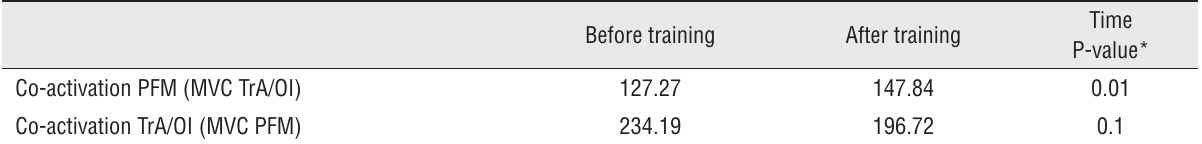
Table presents muscular response (co-activation) following MVC of PFM or TrA/OI, comparing the time of evaluation before and after training. Values expressed in percentage (5). Note increase of co-activation of PFM when MVC was solicited to TrA/OI pfM = pelvic floor muscles MvC = maximal voluntary contraction TrA/OI = transversus abdominis/oblique internal *ANOvA for repeated measures with transformation by posts. Power of sample: